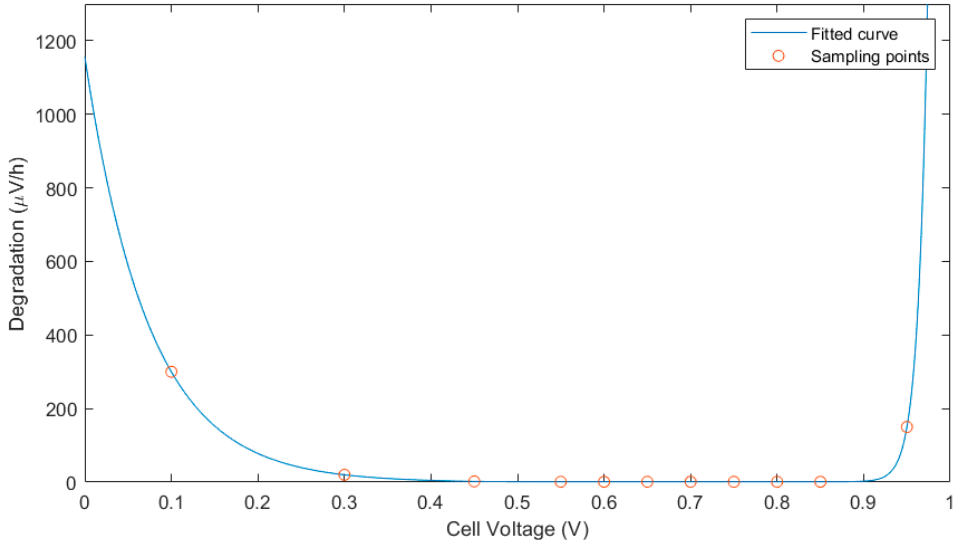
Figure 11. Degradation curve at different cell voltages for an FC (own figure based on [17]).